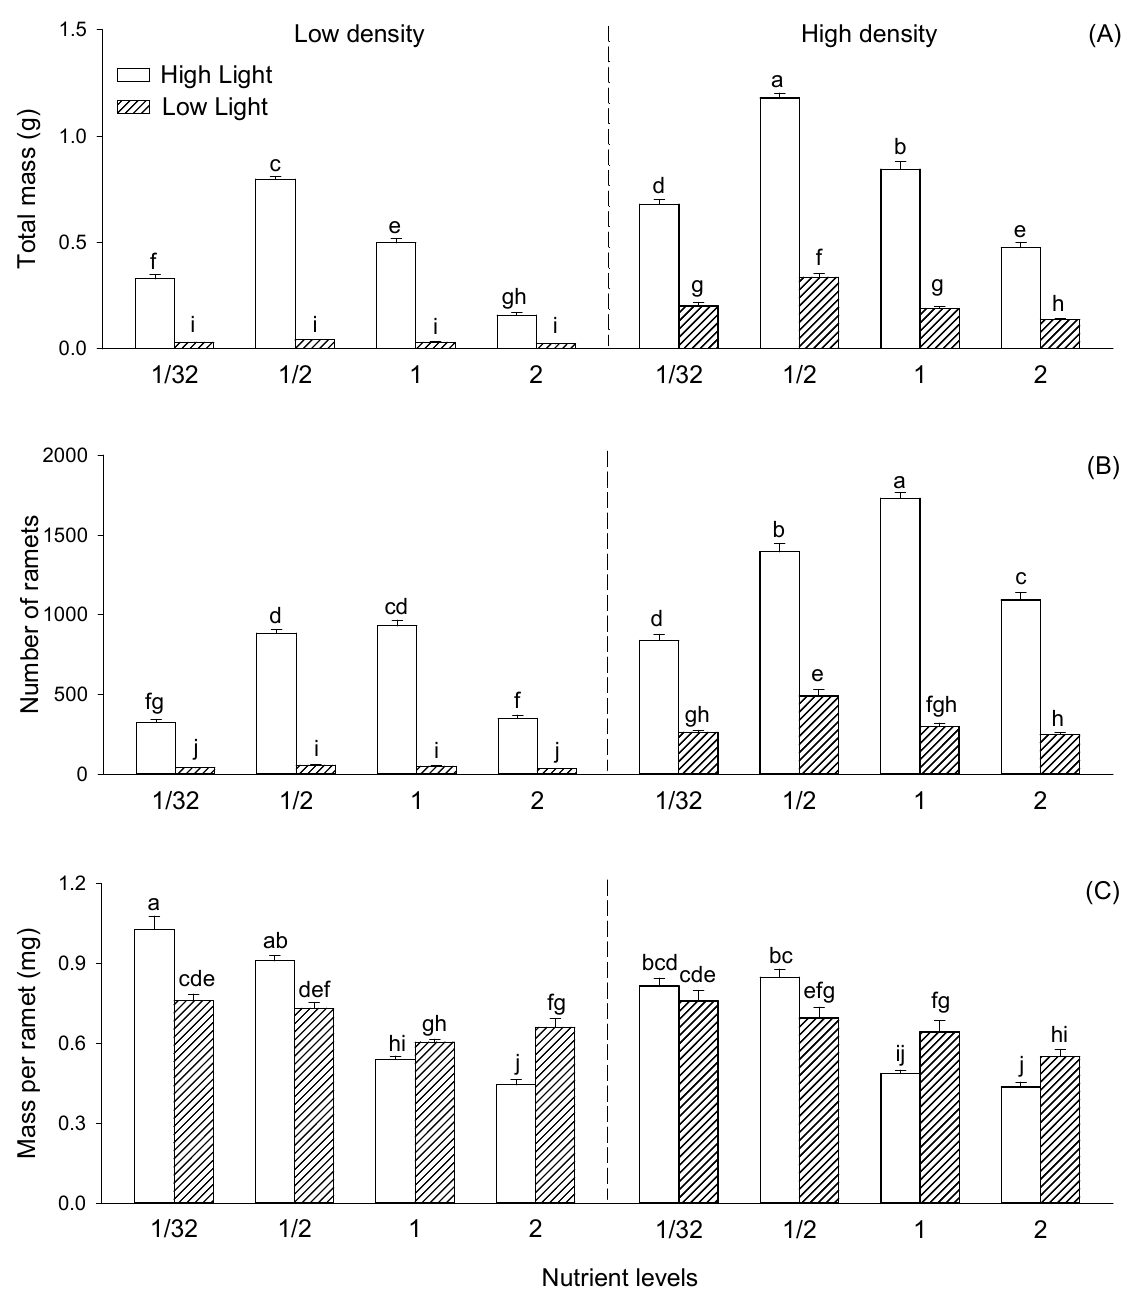
Figure 3. Total mass ( A ), number of ramets ( B ) and mass per ramet ( C ) of Spirodela polyrhiza in response to nutrient availability, initial density and light intensity for the first phase of Experiment 2. The values are means and standard errors. Different letters indicate significant differences among treatments. See Table 2 for ANOVA results.